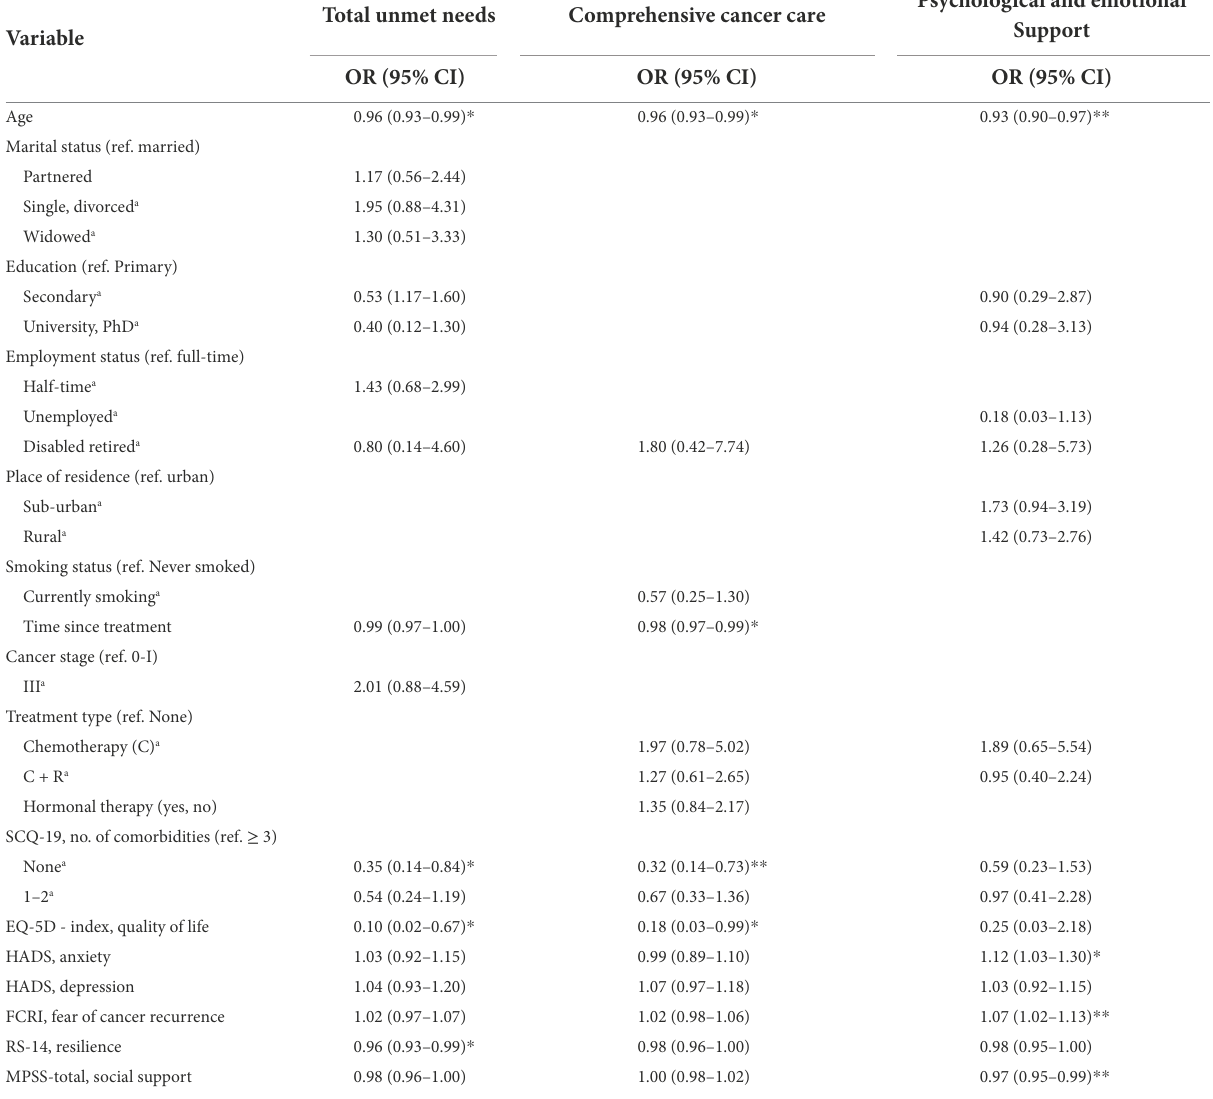
TABLE 4 Final logistic regression models predicting total unmet needs and unmet needs in the comprehensive care and psychological and emotional support